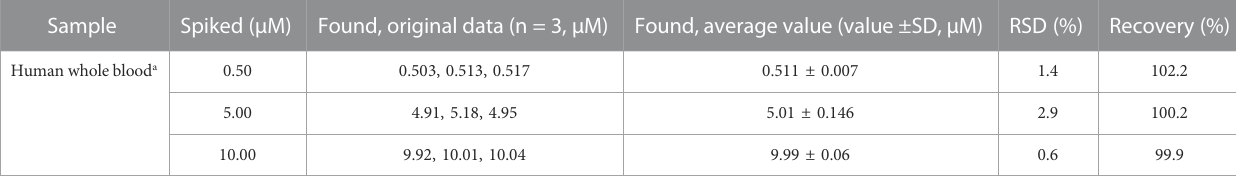
TABLE 1 Determination of NE in human whole blood samples. Sample Spiked ( μ M) Found, original data (n = 3, μ M) Found, average value (value ±SD, μ